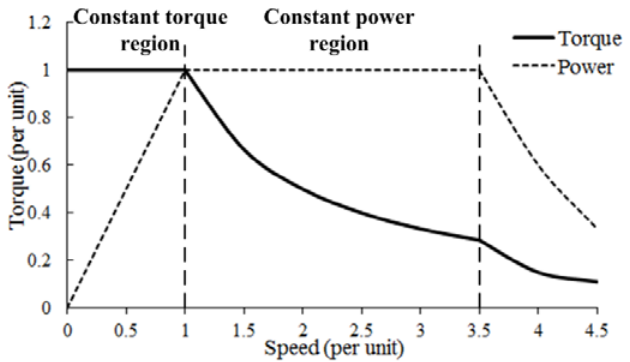
Figure 2. Torque and power requirements for the electric drive systems [4].